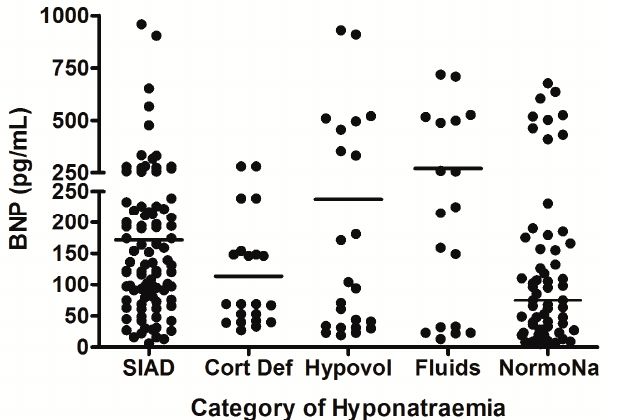
Figure 3. Comparison of brain natriuretic peptic (BNP) levels between different patient groups in patients with hyponatremia following SAH; each point represents an individual BNP measurement; all comparisons between groups were non significant ( p > 0.05); adapt from [6] with